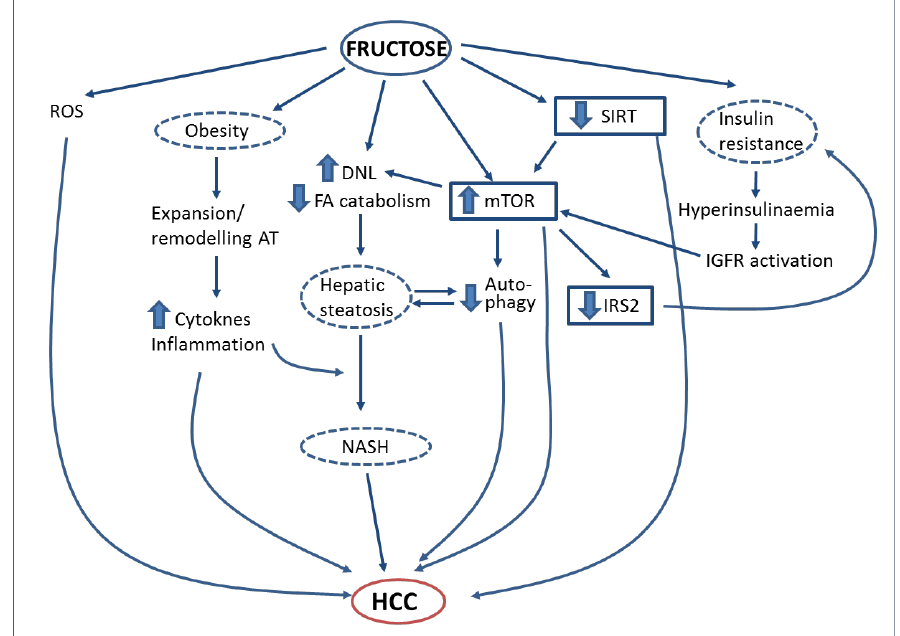
Figure 1. Proposed mechanisms by which fructose may promote hepatocellular